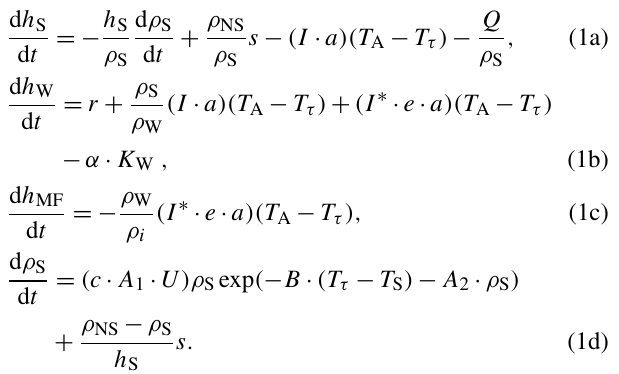
Figure 1. A column of snow, firn and ice as modelled by the single- layer (a) and multi-layer (b) version of the snow–firn